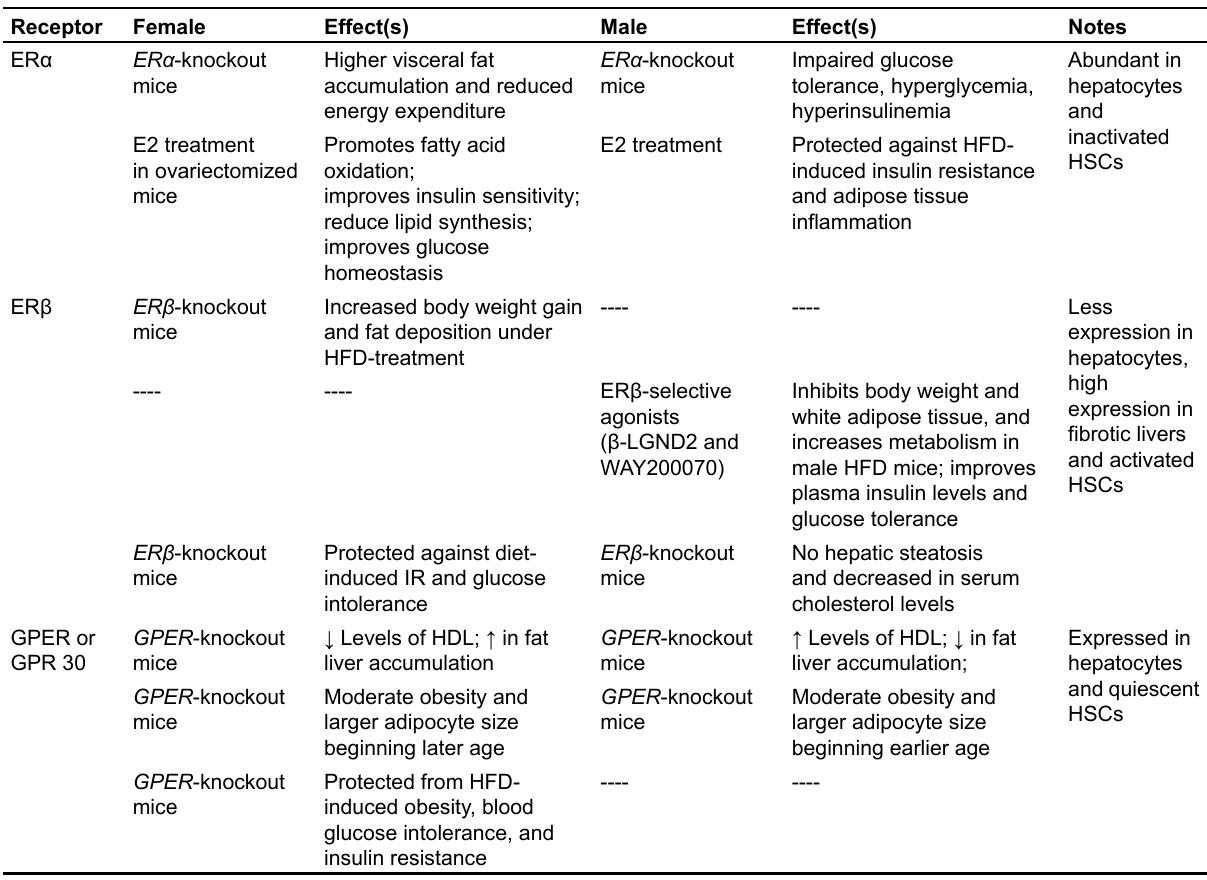
Table 2. Estrogen receptors and its role in sexual dimorphism of NAFLD